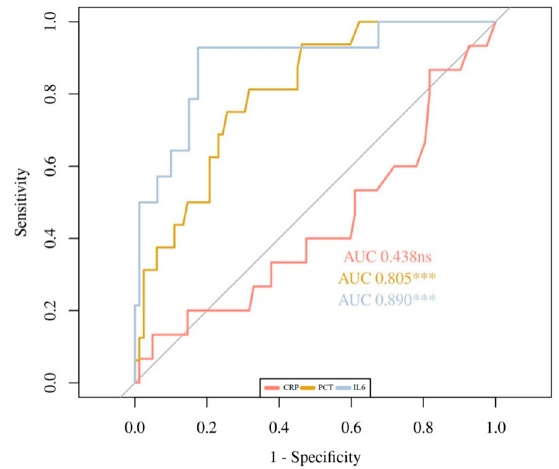
Figure 1. ROC Curves of CRP-1, PCT-1, and IL6-1. ns: non significance, *** p < 0.001.